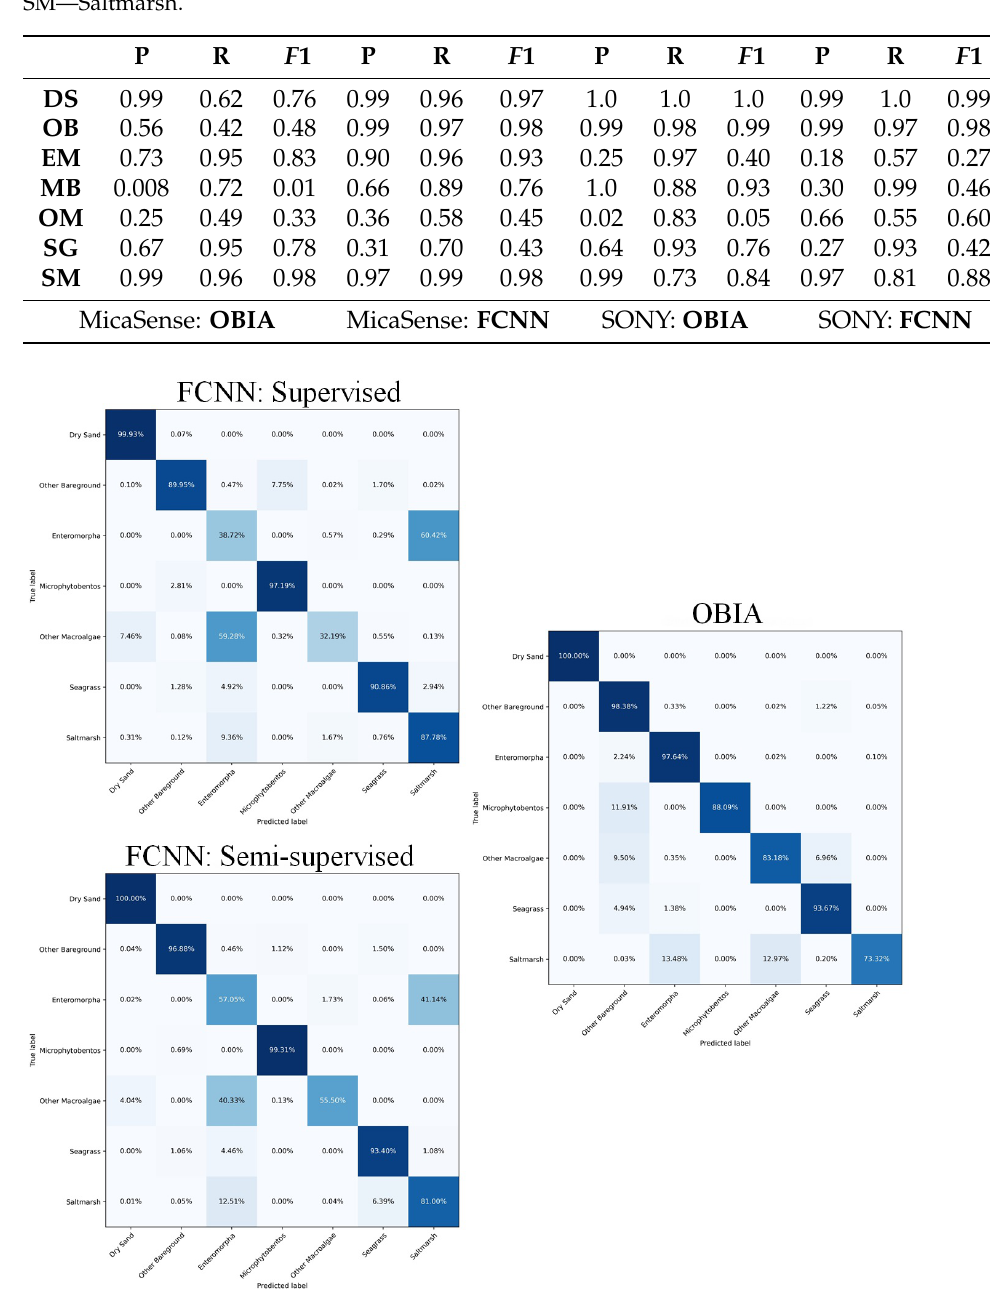
Figure 7. Confusion matrices for both methods using the SONY